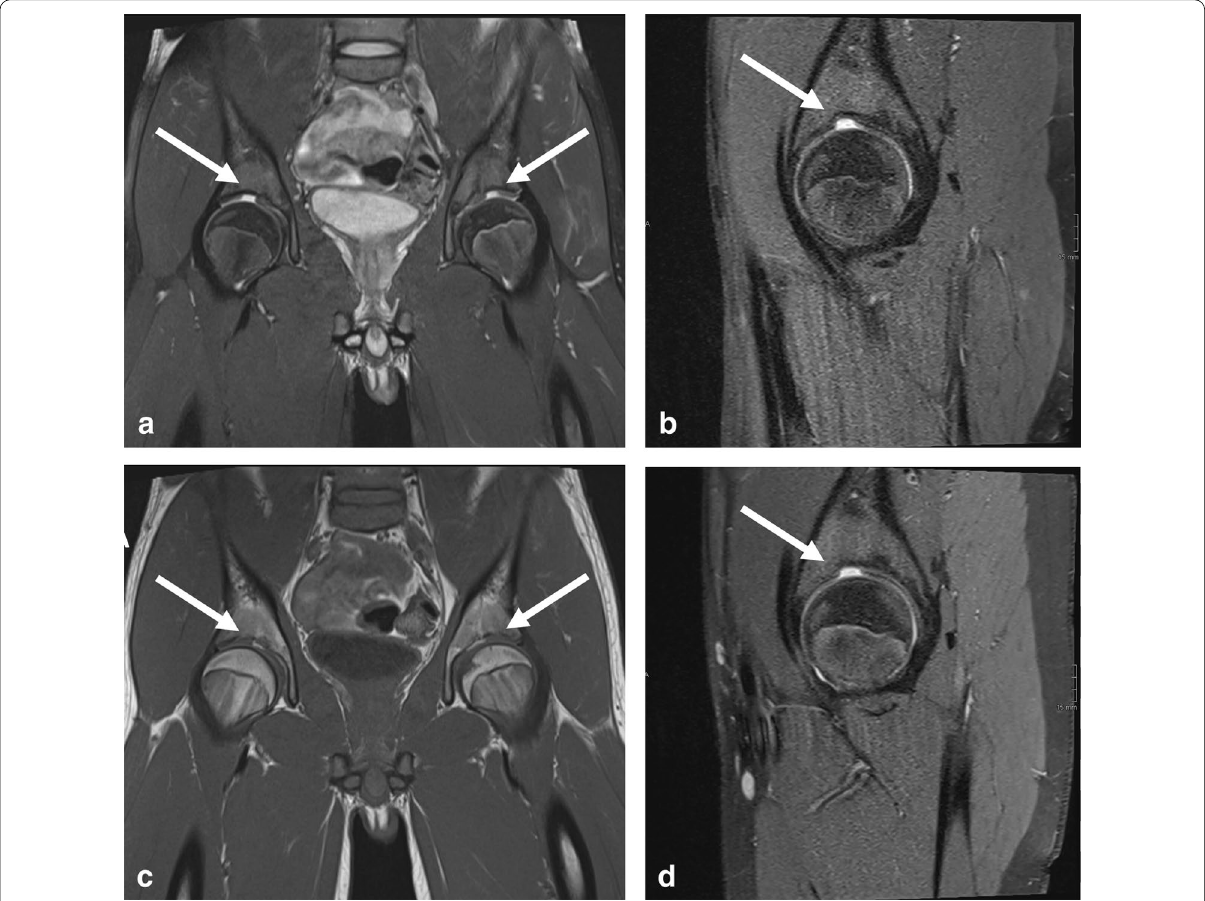
Fig. 3 Hip-MRI of a 15-years-old, male participant without contrast with bilateral SAF type 1 (white arrow): Proton density weighted (PD) coronal both sides ( a ), PD sagittal right side ( b ), T1 weighted coronal both sides ( c ) and PD weighted sagittal left side ( d